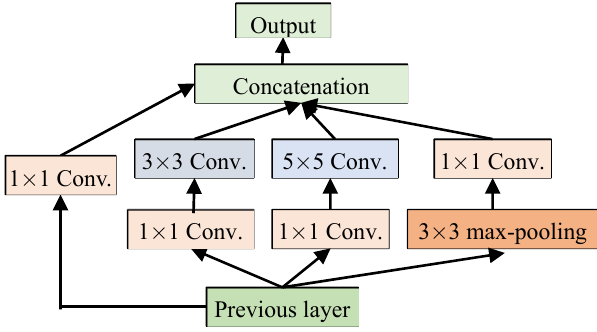
Figure 2. The structure of Inception V1.